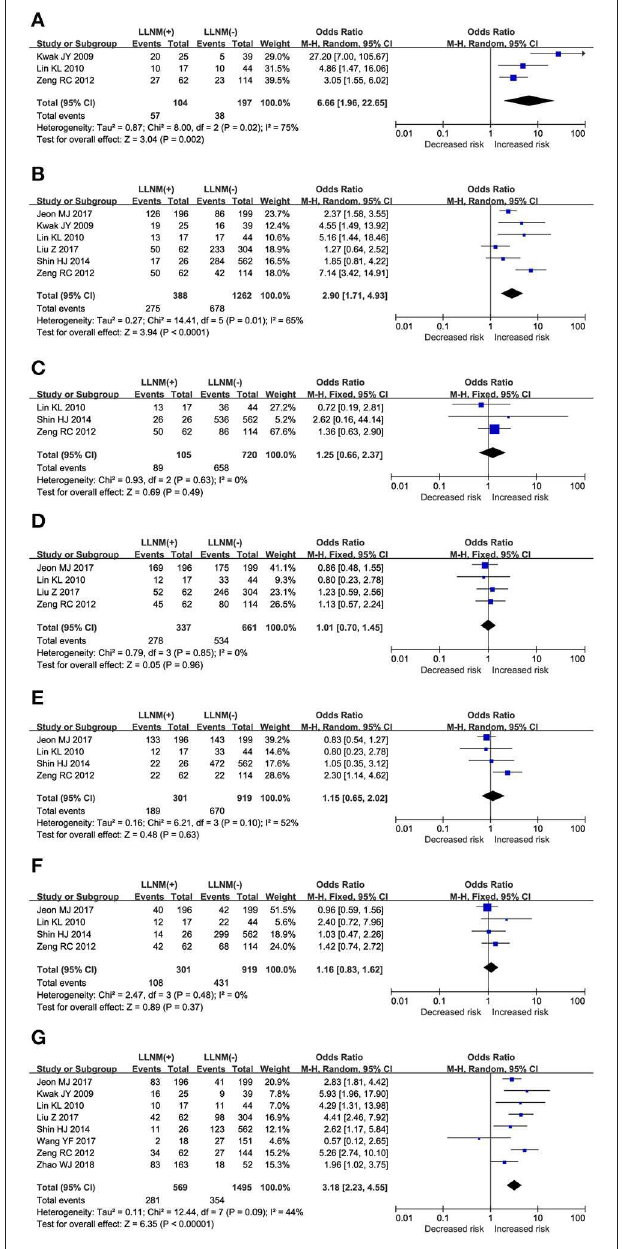
FIGURE 3 | The role of ultrasonic risk factors for LLNM in PTMC. Forest plots for the effects of (A) Contact > 25% thyroid membrane. (B) Calcification. (C) Composition. (D) Echo. (E) Margin. (F) Shape. (G) Location.